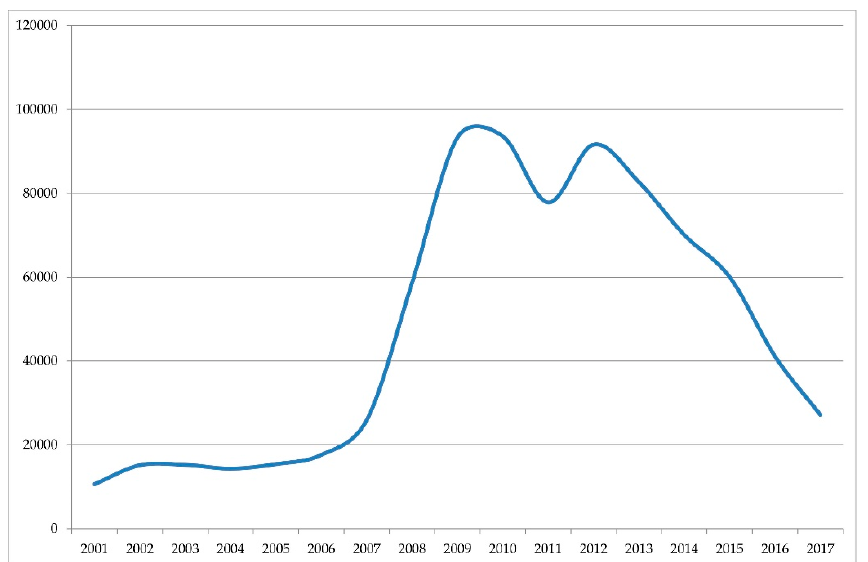
Figure 1. Number of the foreclosures initiated on homes per year in Spain. Data: General Council of the Judiciary. Own production.